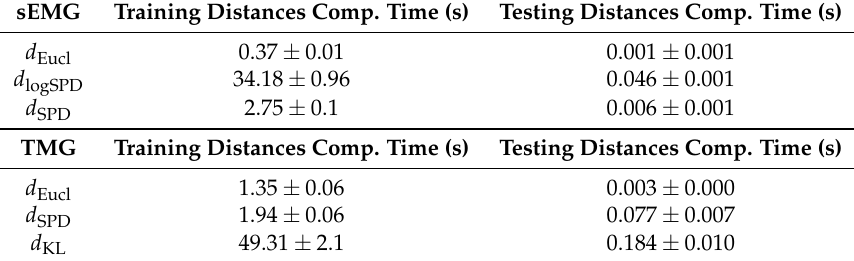
Table 4. Computation (comp.) time for the different kernel distances using surface electromyography (sEMG) or tactile myography (TMG) as input for the regression model. The time to compute training distances is the time needed to compute the distances between all training data points. The time to compute testing distances is the time needed to compute the distance of a new test data point with all training data